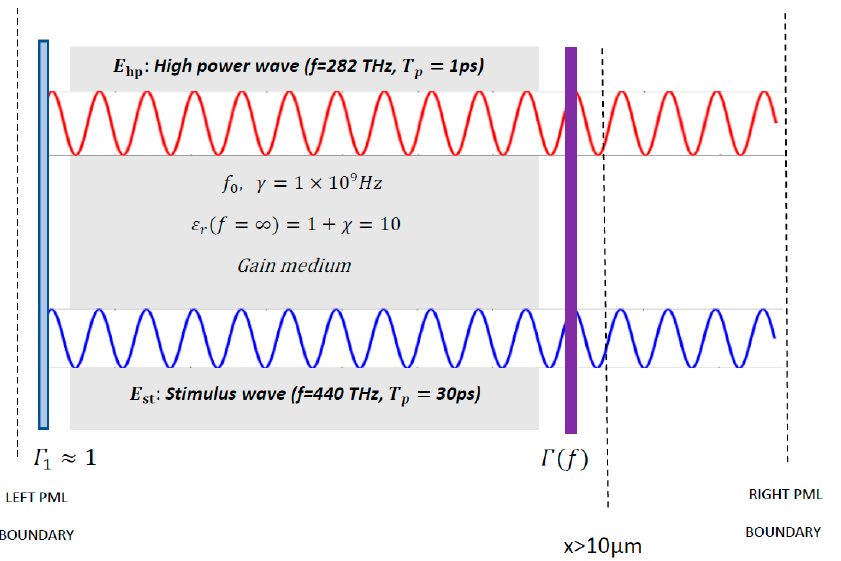
Figure 4. Configuration of the cavity.